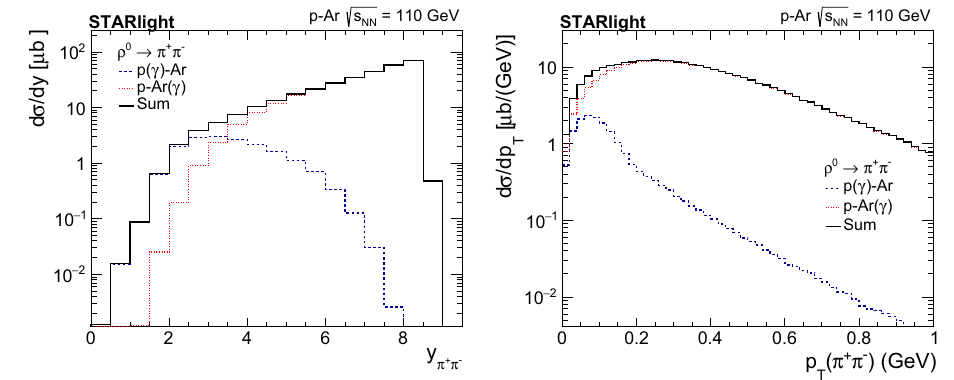
Fig. 2 Rapidity (left panel) and transverse momentum (right panel) distributions for the exclusive ρ photoproduction in pAr collisions at √ s = 110 GeV. The predictions associated to γ p and γ Ar interactions